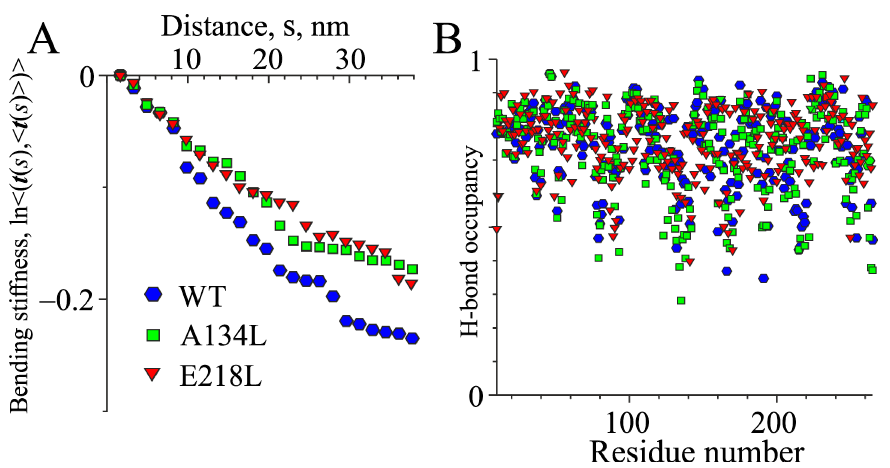
Figure 7. The result of the molecular dynamics (MD) simulation of the WT Tpm and the Ala134Leu and Glu218Leu Tpm mutants. Left: characteristic of the bending stiffness (see Materials and Methods section, less steep dependency corresponds to higher stiffness) ( A ); right: the occupancies of the backbone h -bonds ( B ).